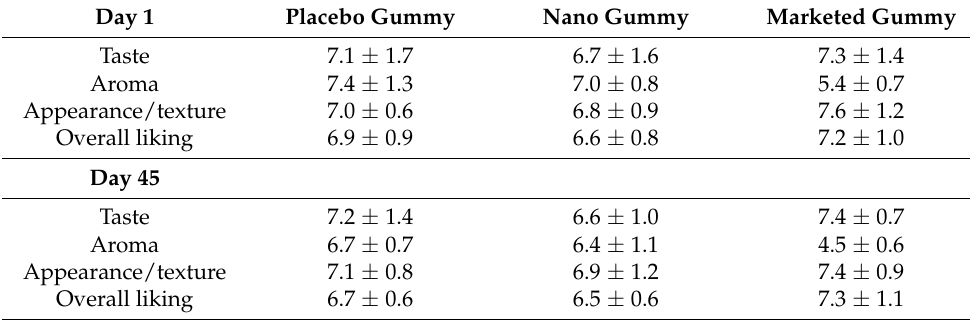
Table 6. Average scores from the sensory evaluation on Day 1 and day